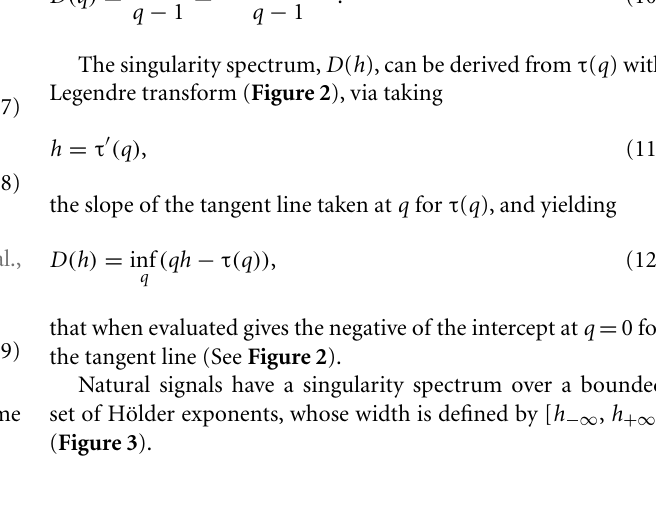
FIGURE 1 | Monofractal and multifractal temporal scaling. Three kinds of fractals are shown to demonstrate scale-free property of these structures: a stationary monofractal (fractional Gaussian noise), a non-stationary monofractal (fractional Brownian motion), and a multifractal (Devil’s staircase with weight factors p 1 = p 3 = 0.2, p 2 = 0.6). Every fractal is self-similar: fGn and fBm in a statistical sense (as in empirical structures and processes where fractality is manifested in equal distributions, only) and Devil’s staircase in an exact manner (as self-similar structuring in mathematical, i.e., ideal fractals is exact). For fractals, descriptive statistical measures [for example mean, variance, fluctuation ( F q ) etc.] depend on the corresponding scale in a power